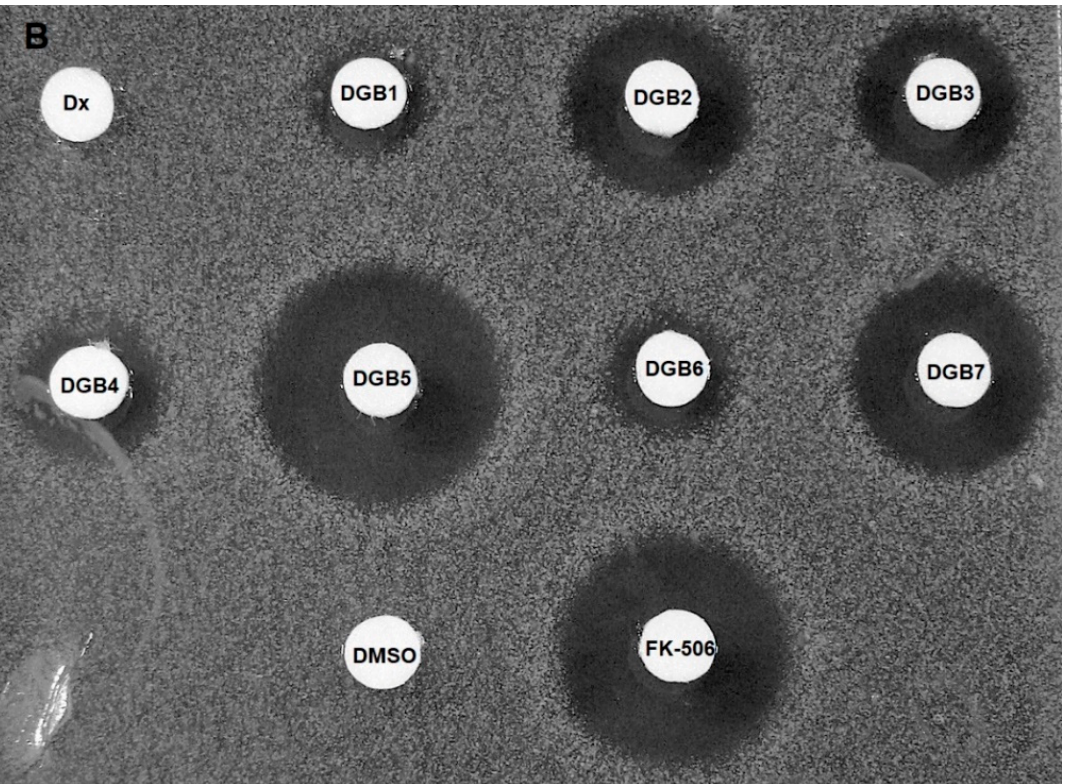
Figure 2. Chemosensitization assay by disk diffusion method: Digoxin (Dx) and its derivatives (DGB1–DGB7) were added to filter paper disks and incubated on plates containing the strain AD/124567 in the ( A ) absence or ( B ) presence of fluconazole (150 μ g/mL). Dimethyl sulfoxide (DMSO) and FK-506 were used as controls. These images are representative of three independent experiments.